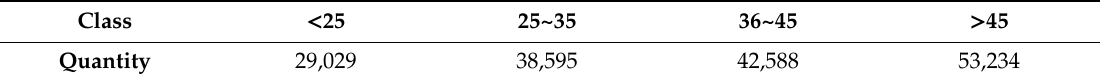
Figure 9. Examples from the cross-age celebrity dataset (CACD2000) face database. Table 11. Age ranges in the CACD2000 database.